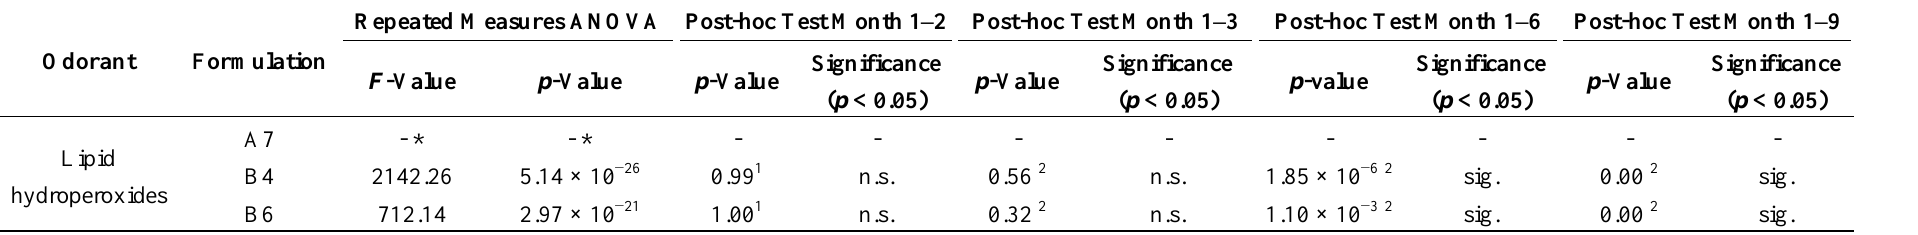
Table 11. Statistical data on one-way repeated ANOVA combined with a post-hoc test 1,2 for pairwise comparison of the means: analysis of lipid oxidation via lipid hydroperoxides over storage period.